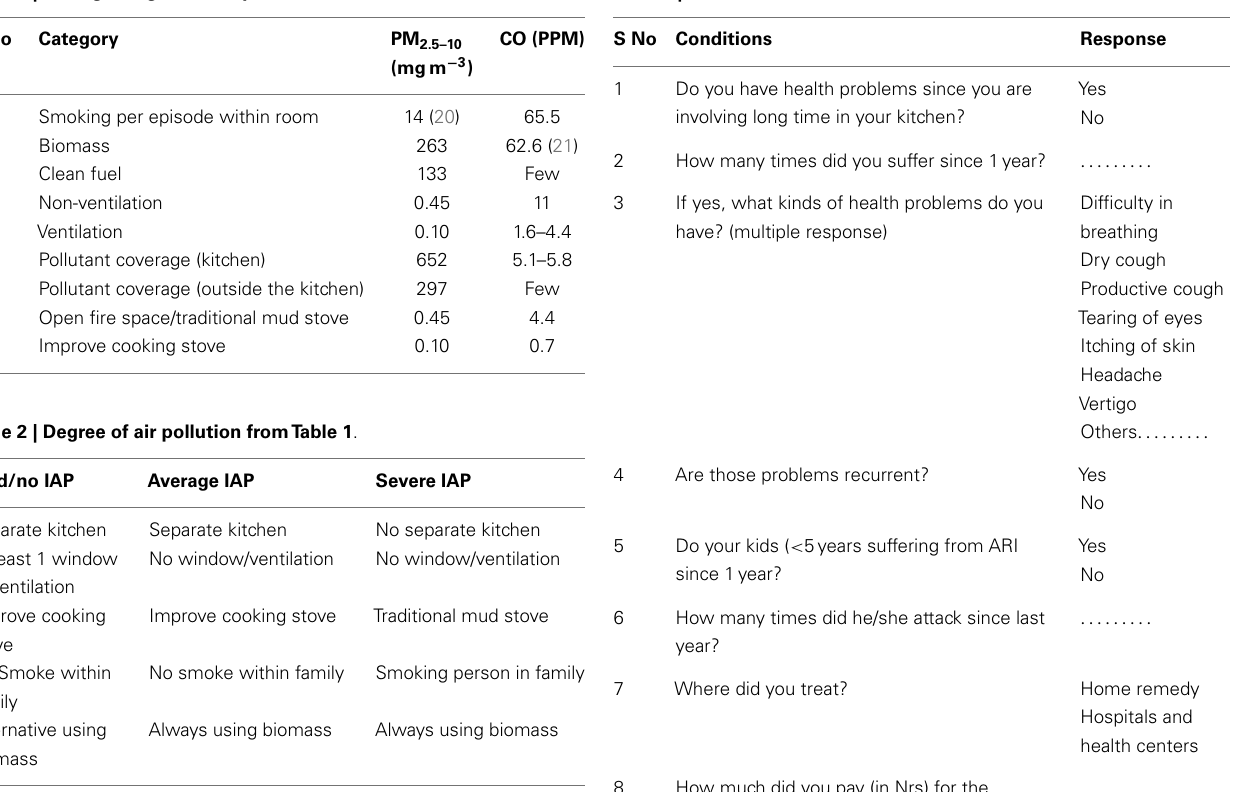
Table 3 |Assessment of health status